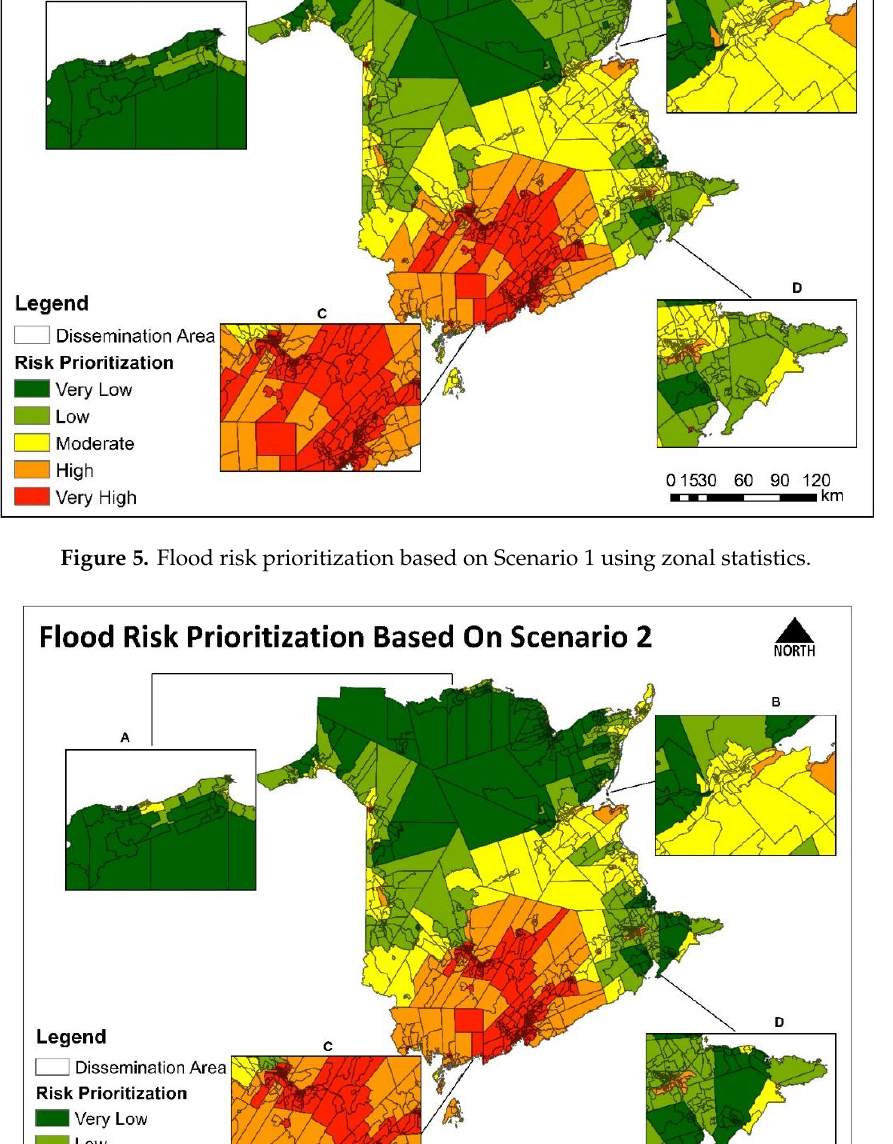
Figure 7. Flood risk prioritization based on scenario 3 using zonal statistics.